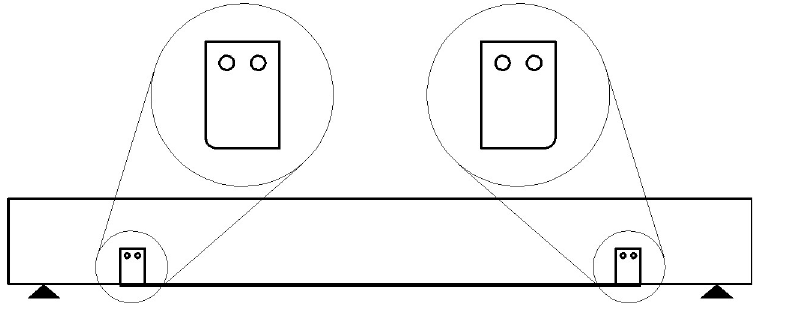
Fig 9. Rounded edge of the outer edge of the steel channels in beam